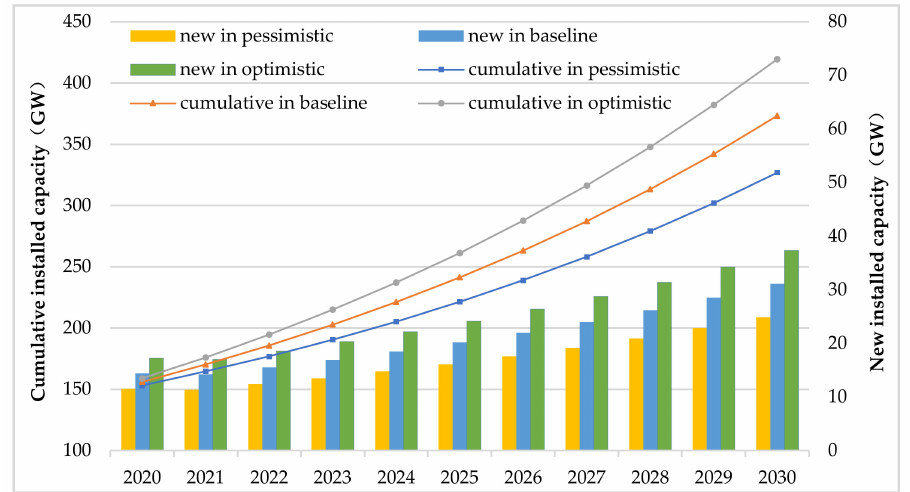
Figure 3. New and accumulative installations of CPV under different investment